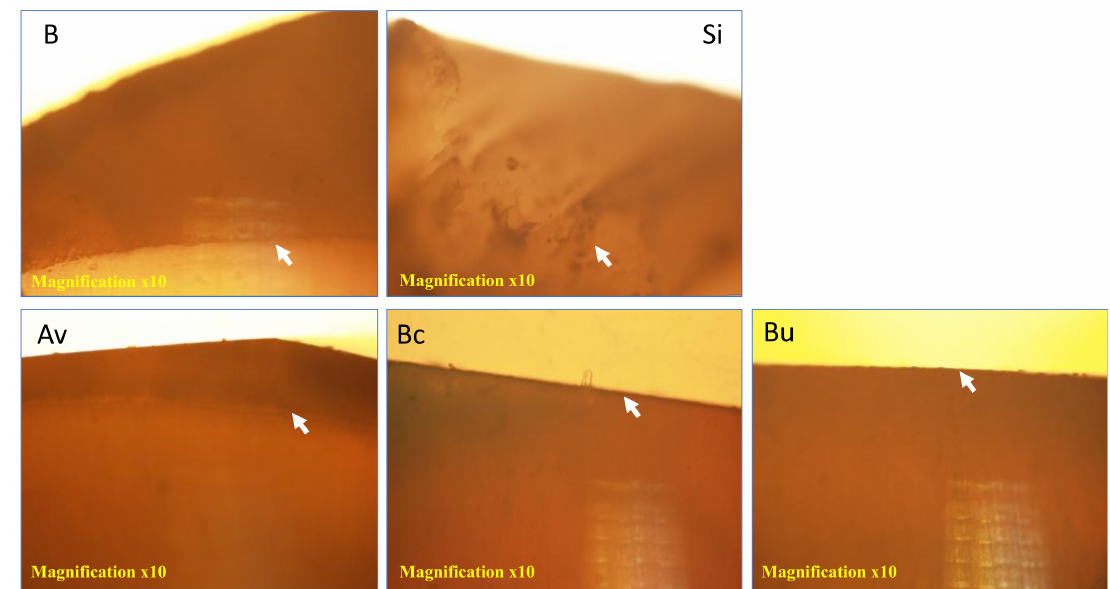
Figure 9. Photomicrographs of a longitudinal section of enamel under the sealed areas taken with polarized light. Dark bands at the surface (arrows) represent the demineralized enamel. (B) Blank and (Si) Seal-it sealant represent images under the negative control and non-bioactive sealant, respectively. (Av) ACTIVA KIDS Bioactive—restorative, (Bc) BioCoat ® sealant and (Bu) BeautiSealant show images of enamel under the bioactive